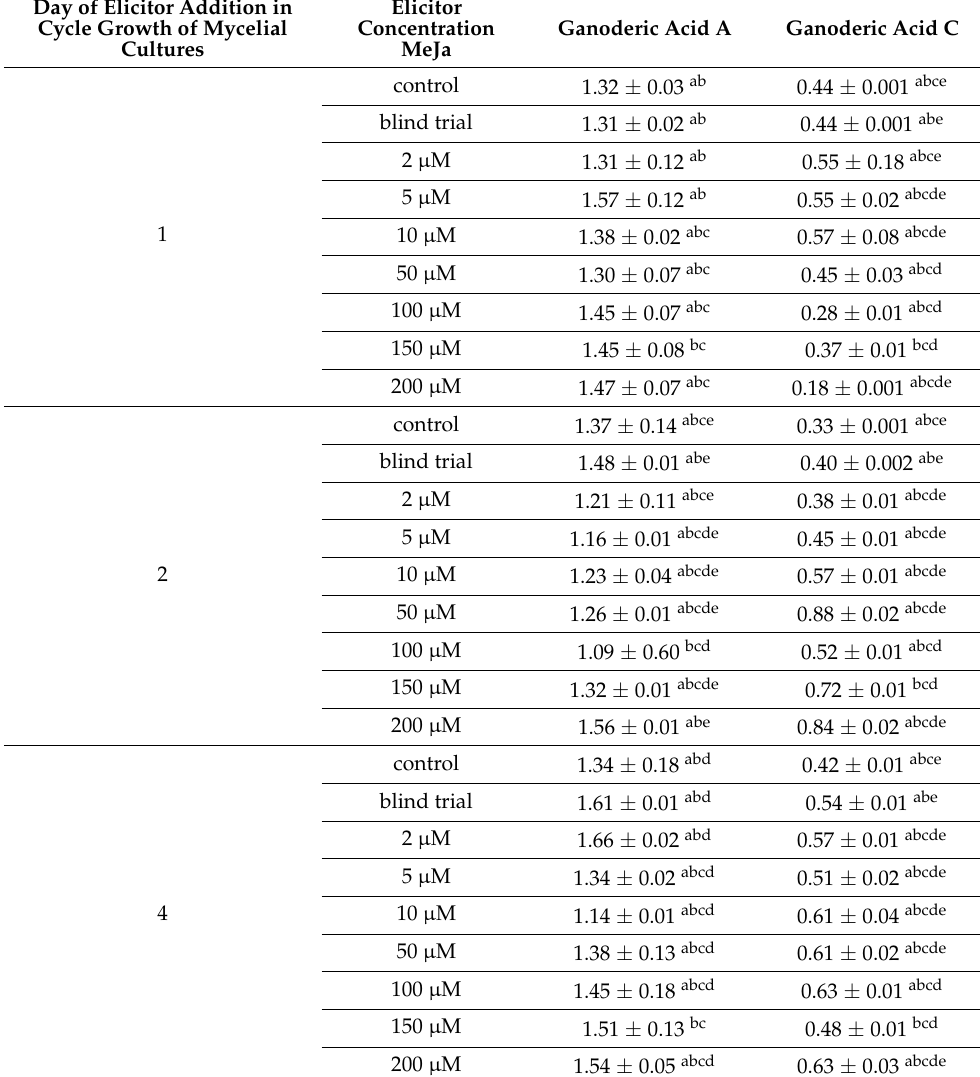
Table 1. Amounts of ganoderic acids A and C (mg/g DW ± SD) in extracts from Ganoderma applanatum mycelial cultures after elicitation with methyl